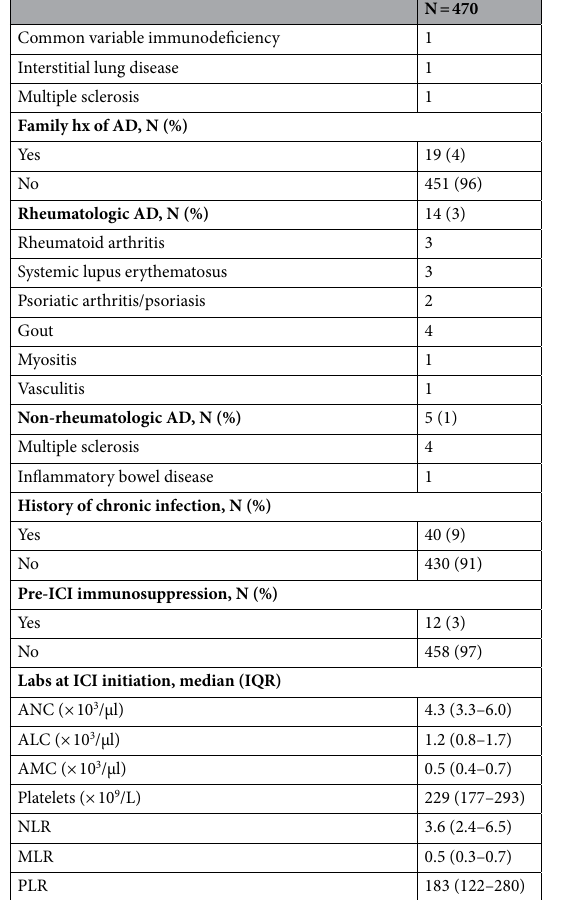
Table 1. Demographic characteristics. IQR interquartile range, ECOG Performance status Eastern Cooperative Oncology Group, ICI immune checkpoint inhibitor, AD autoimmune disease, hx history, Anti-PD-1 anti- programmed cell death 1, Anti- PD-L1 anti-programmed cell death ligand 1, Anti-CTLA-4 anti-cytotoxic T-lymphocyte antigen 4, ANCA negative vasculitis anti-neutrophil cytoplasmic antibody negative